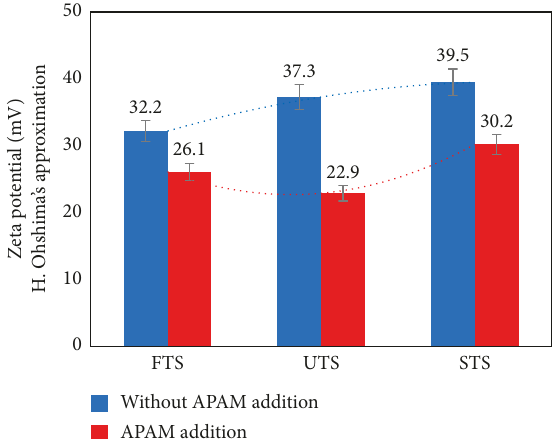
Figure 7: Results of the zeta potential tests based on H. Ohshima’s